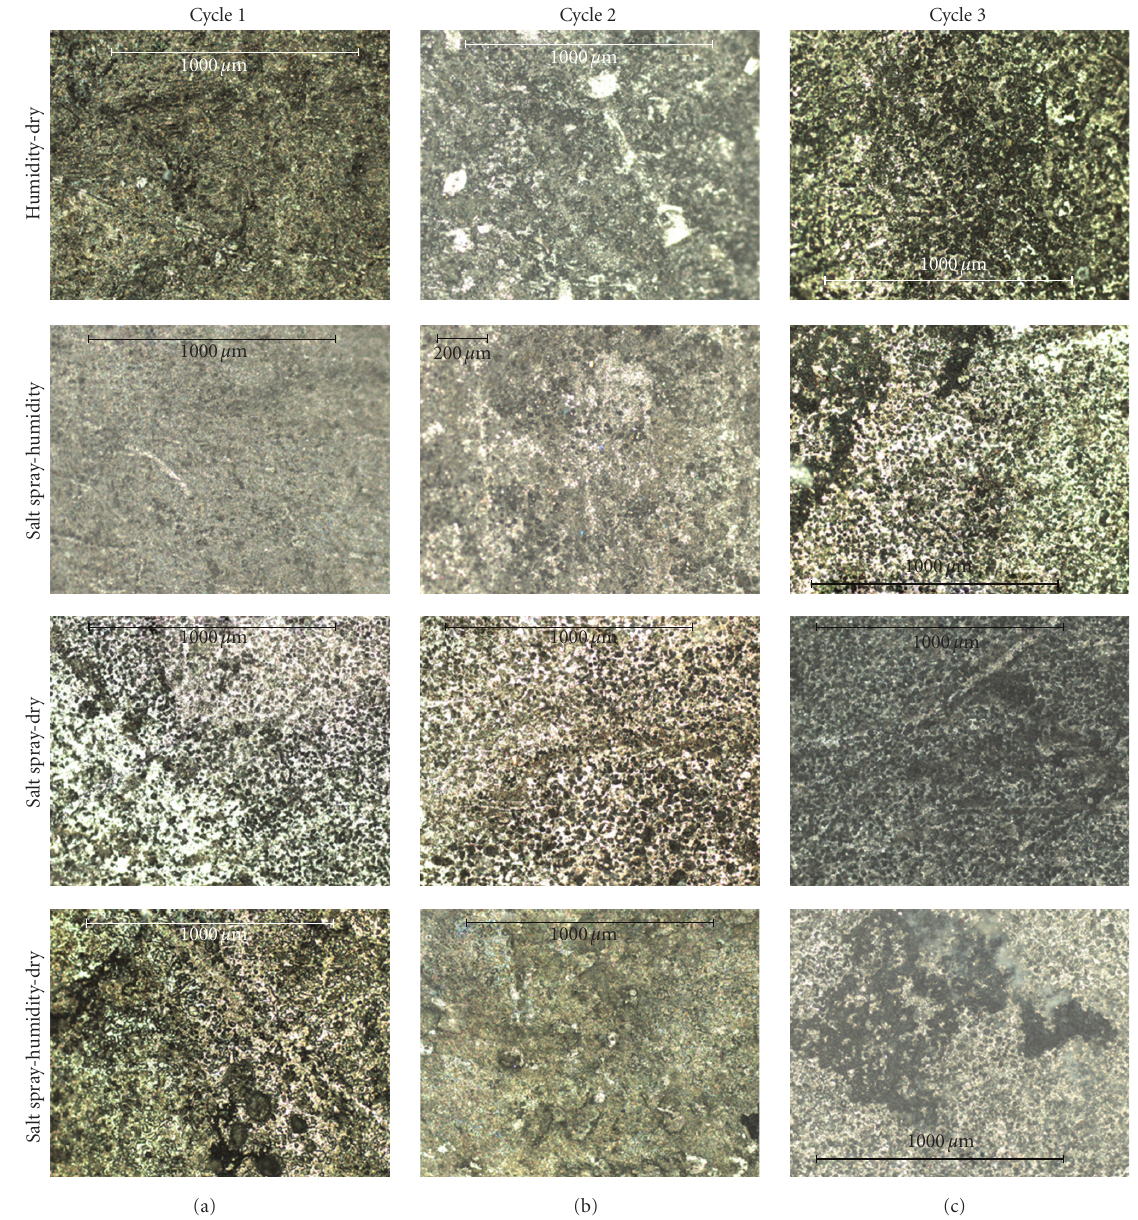
Figure 9: Micrographs of the AE44 coupons arranged by test condition based on cycle number. The scale for all of the pictures is 1000 μ m long. Notice the presence of dark spots, indicating the formation of pits, specifically in the first and second columns, as well as the connection of the pits, specifically in the third